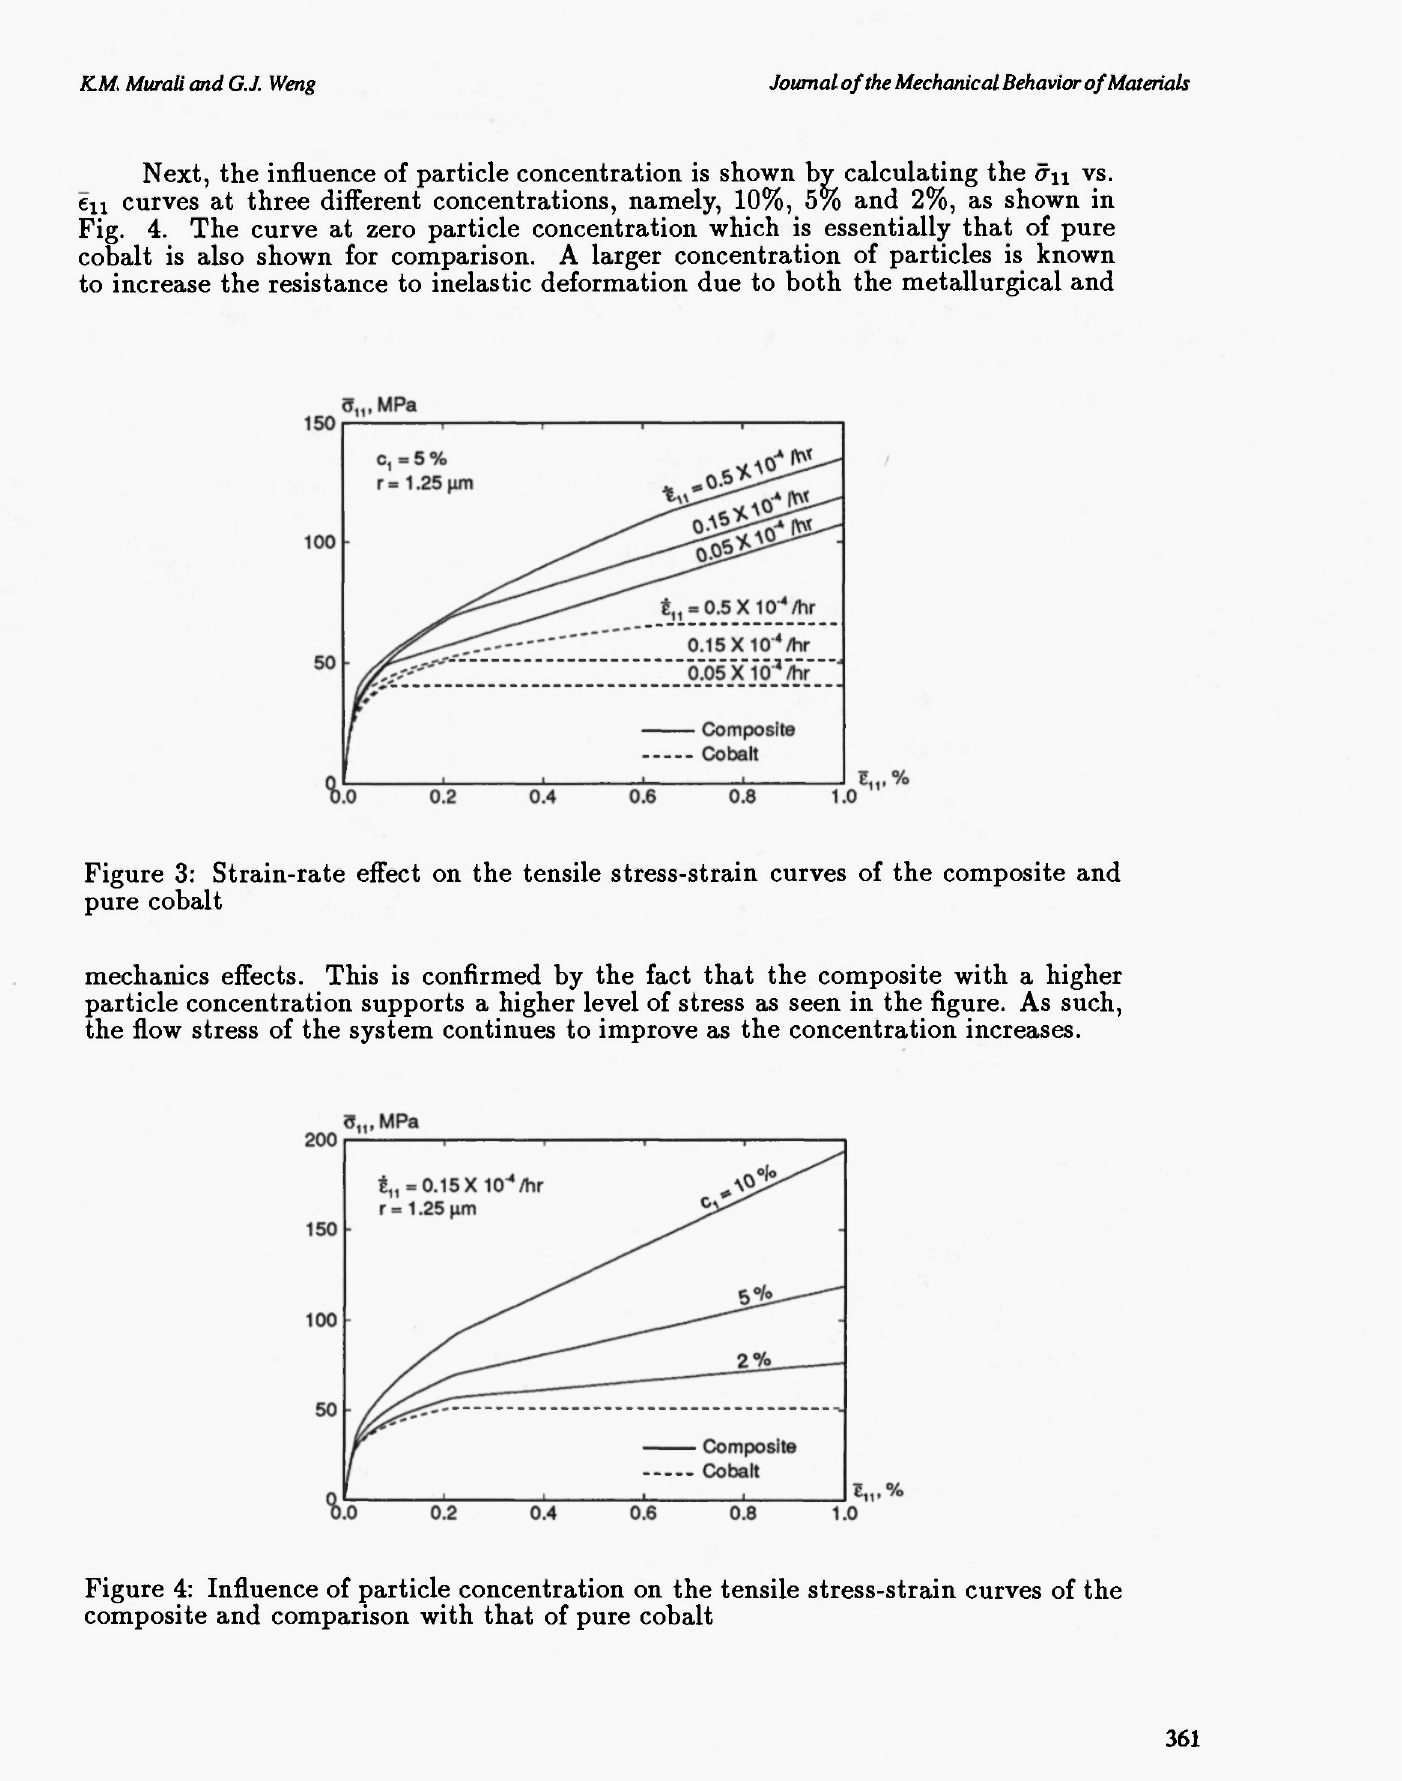
Figure 4: Influence of particle concentration on the tensile stress-strain curves of the composite and comparison with that of pure